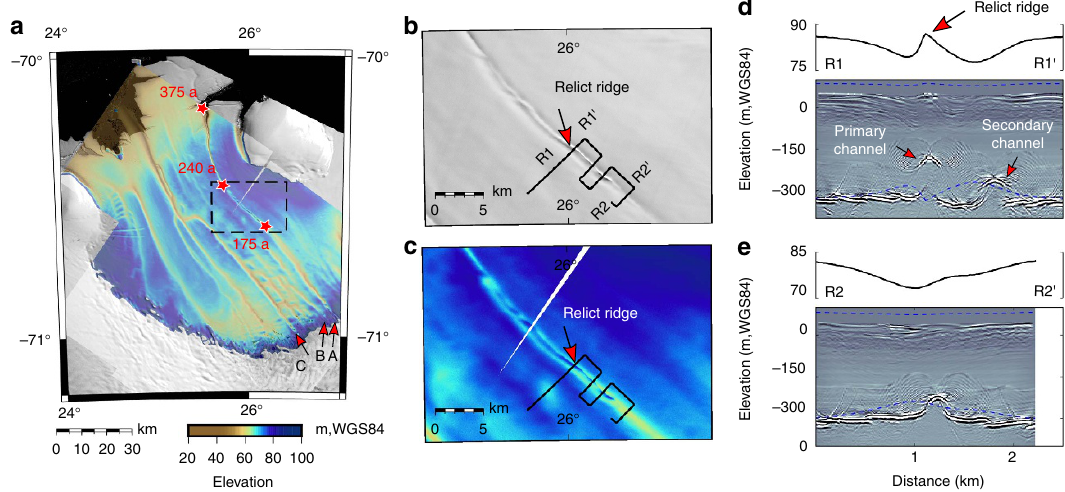
Figure 7 | Relict surface ridges within ice-shelf channels. ( a ) TanDEM-X surface elevation illustrating the surface depression corresponding to ice-shelf channels. Advection times of present-day velocities are marked with red stars. The black box is enlarged in ( b ) where the Landsat image shows an ice-shelf channel being subdivided by a surface ridge ( c ). This ridge is incised by a primary channel accompanied by a secondary channel ( d ). Farther upstream (R2–R2 0 , ( e ), the ice-shelf channel is more typical consisting of one surface depression and one basal incision. The blue lines correspond to the hydrostatic ice thickness and show that the surface ridge and the ice-shelf channel are not in hydrostatic